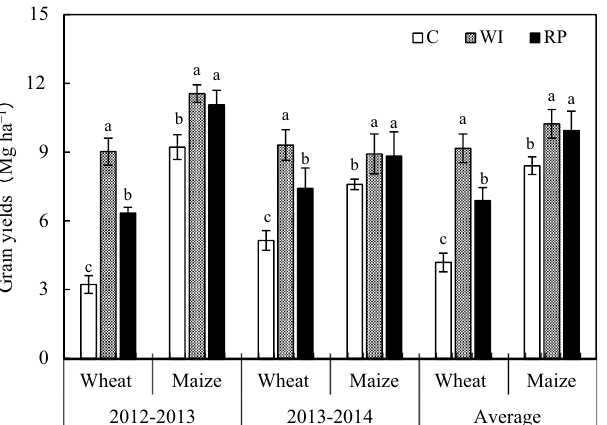
Figure 1. Effect of different planting strategies on grain yields during wheat and maize periods. C, conventional rain–fed flat planting; WI, well-irrigation planting; RP, ridge-furrow planting with plastic film mulch over the ridge 23,52 . The same in subsequent figures and tables. Bars are standard error values. Different lowercase letters over error bars indicate significant difference during the same crop growth period at P < 0.05. The same in subsequent